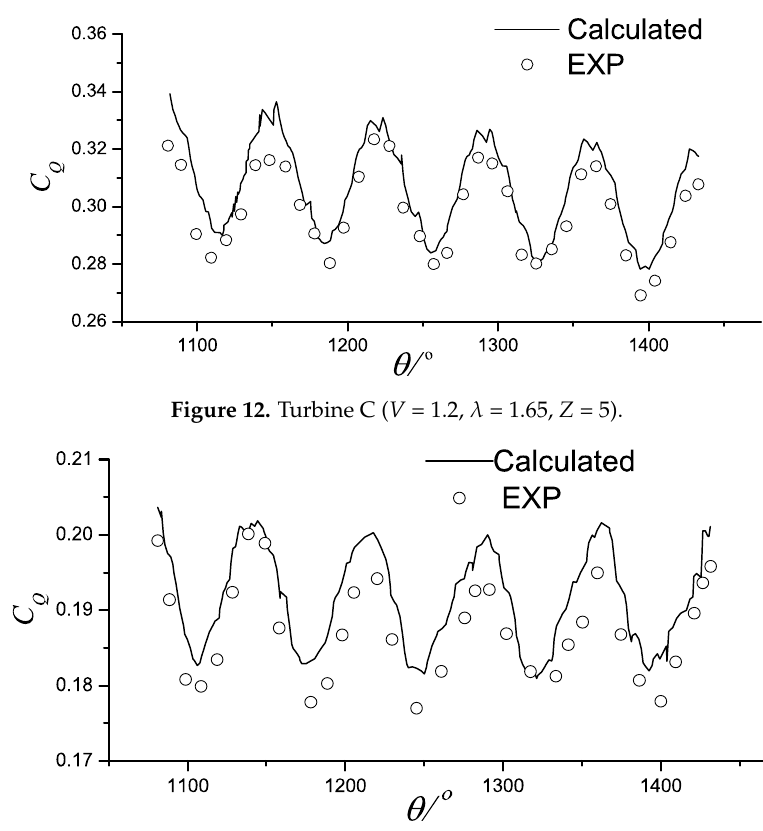
Figure 13. Turbine C ( V = 1.2, λ = 2.23, Z = 5).